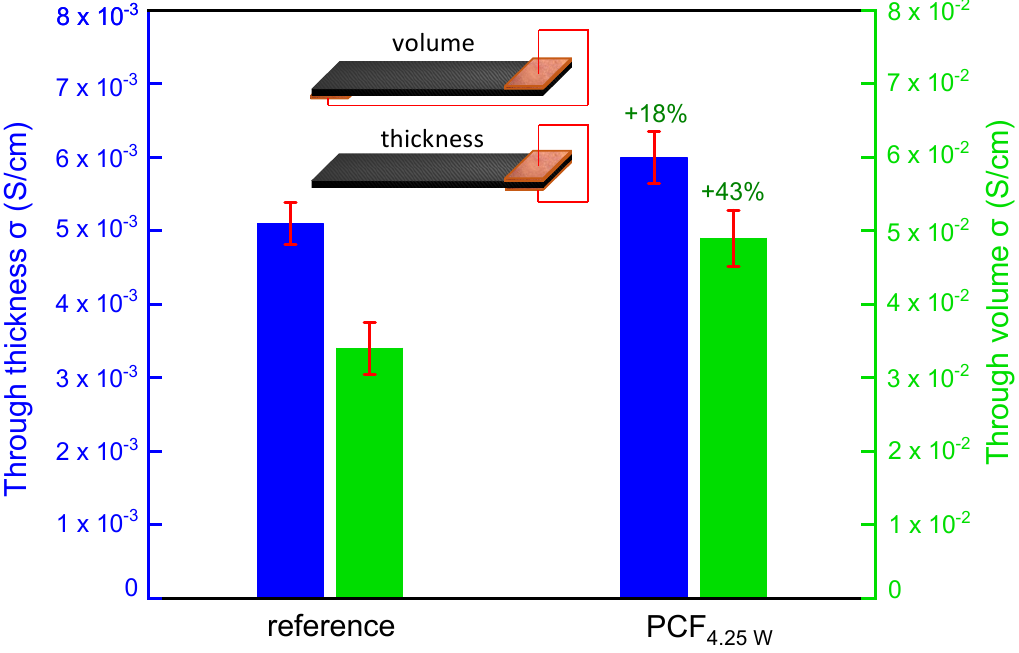
Figure 14. Out of plane electrical conductivity ( σ ) of the fabricated composite structures. Table 3. Mode I interlaminar fracture toughness and electrical conductivity of the fabricated laminates.